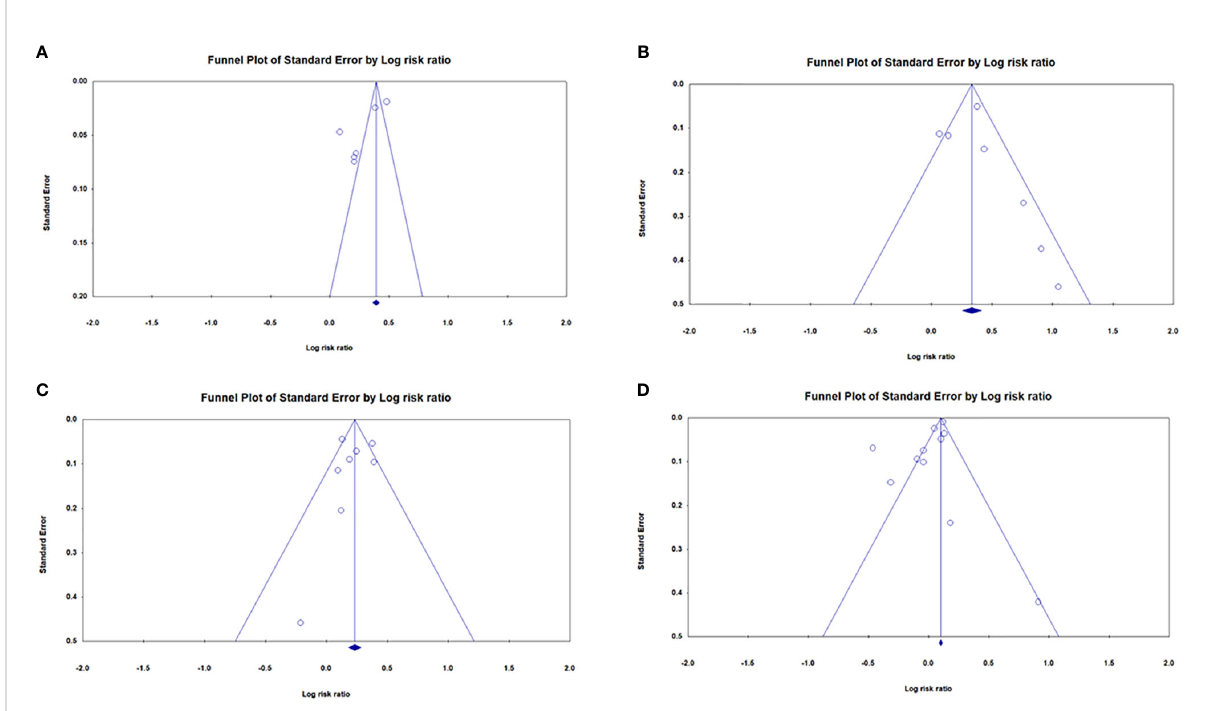
FIGURE 6 Funnel plots for the association between dementia risk and (A) OA, (B) SLE, (C) SS, and (D) RA.